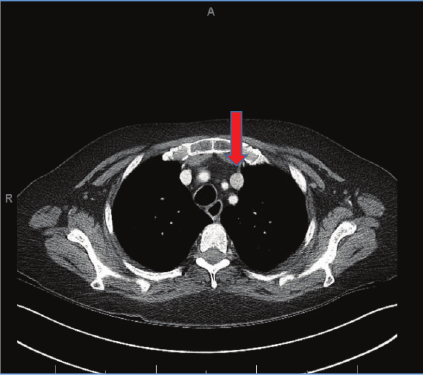
Figure 2: CT thorax visualizing persistent left superior vena cava.